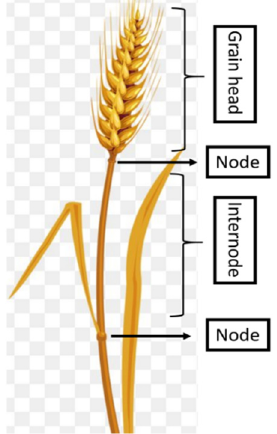
Figure 2. Different parts of a wheat stalk.